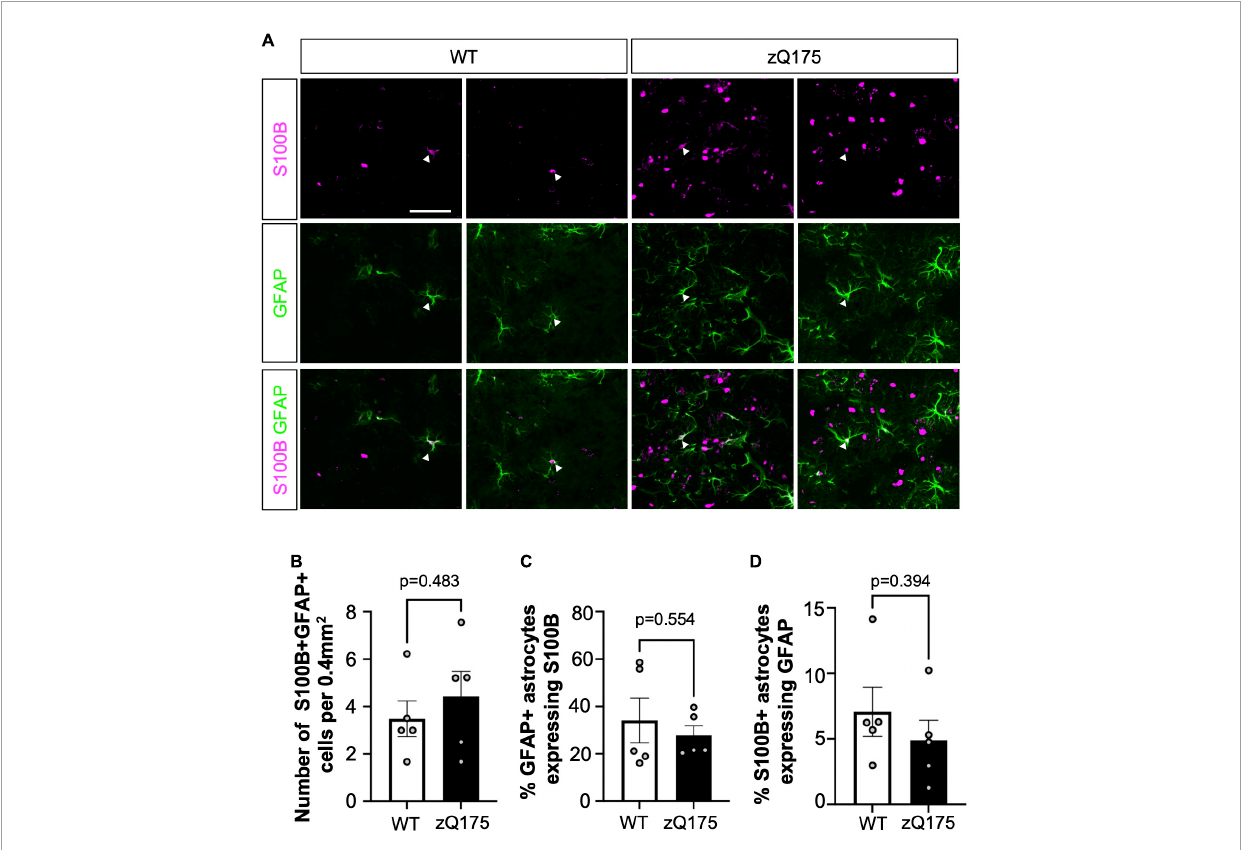
FIGURE2 Dual GFAP + S100B + astrocytes constitute a small portion of striatal astrocytes, and their number is not altered in zQ175 mice. (A) Representative images from 12-month-old WT and zQ175 mice showing S100B and GFAP immunofluorescence in the dorsal striatum. White arrows indicate colocalization. (B) Number of S100B + GFAP + astrocytes per 0.4 mm 2 in the striatum of WT and zQ175 mice at 12 months ( n = 5 mice/genotype). (C) Percent GFAP + astrocytes that express S100B. (D) Percent S100B + astrocytes that express GFAP. Scale bar, 50 µ m. Error bars denote mean ± SEM. Un-paired Student’s t -test [ (B) t = 0.7343, df = 8; (C) t = 0.6163, df = 8; (D) t = 0.8994, df =